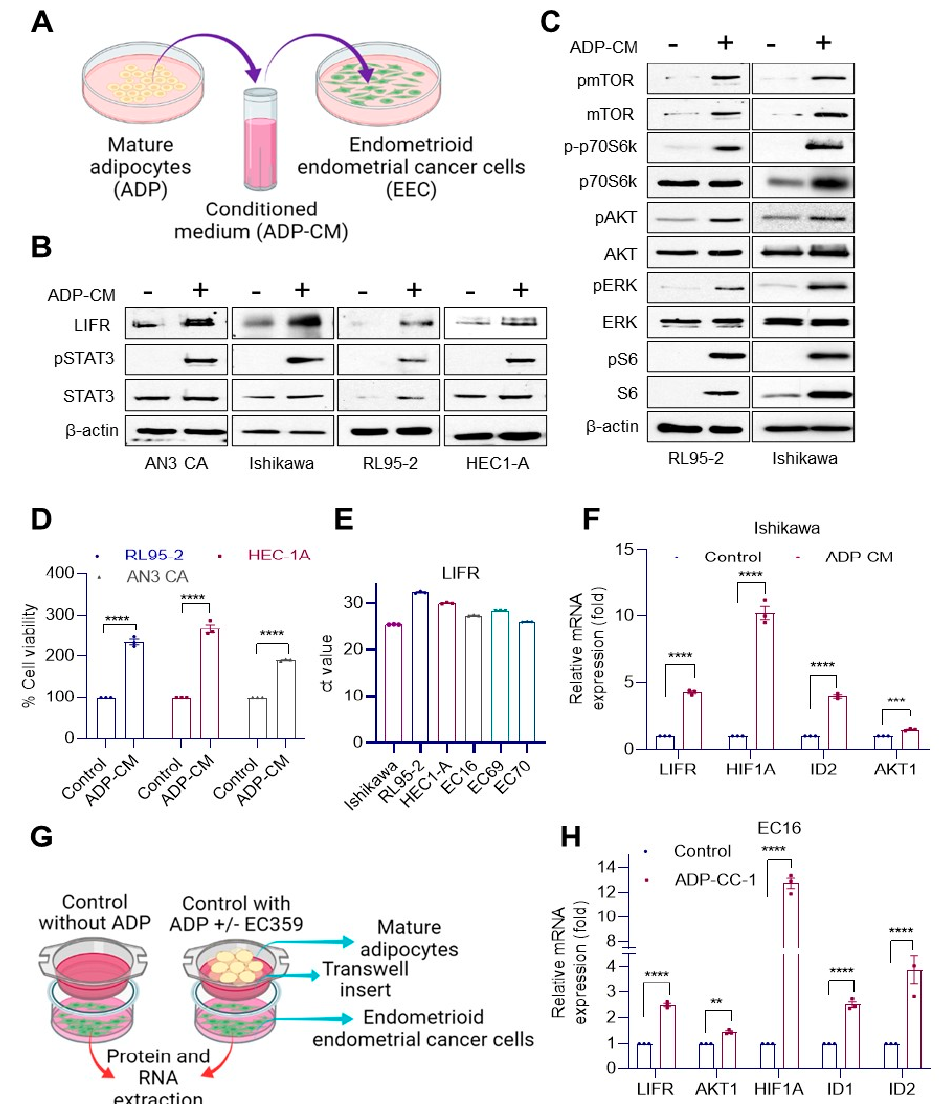
Figure 3. Adipocytes induced LIFR signaling in EEC cells. ( A ) Schematic of ADP-CM treatment of EEC cells. EEC cells were treated with ADP-CM for 24 h, and the expression of LIFR, pSTAT3, STAT3 ( B ) and LIFR downstream signaling ( C ) was determined by Western blotting. ( D ) Effect of adipose conditions on EEC cell proliferation was determined by MTT cell viability assay. ( E ) LIFR gene expression in established and primary EEC cells was analyzed by RT-qPCR. ( F ) Ishikawa cells were incubated with ADP-CM for 24 h, and the expression of LIFR target genes was analyzed by RT-qPCR. ( G ) Schematic of transwell co-culture system. ( H ) Adipocytes were indirectly co-cultured with primary EEC model cells (EC16) using a transwell culture system for 24 h, and the expression of LIFR target genes was analyzed by RT-qPCR. Data are represented as mean ± SE. ** p < 0.01; *** p < 0.001; **** p < 0.0001.